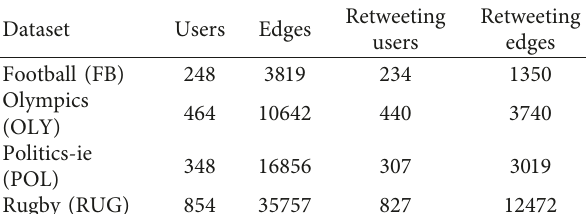
Table 3: Summary of datasets [45].